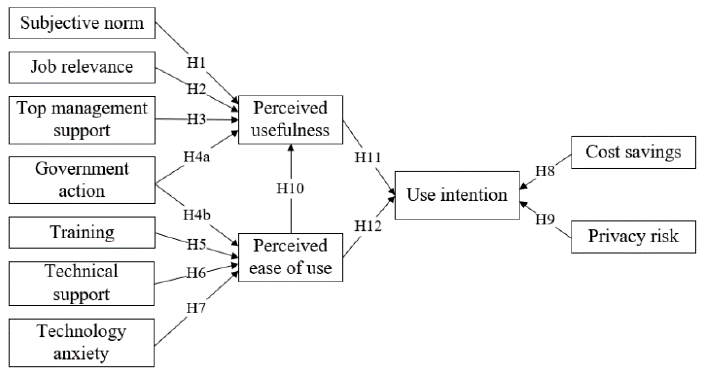
Figure 3. Proposed ISSTAM.